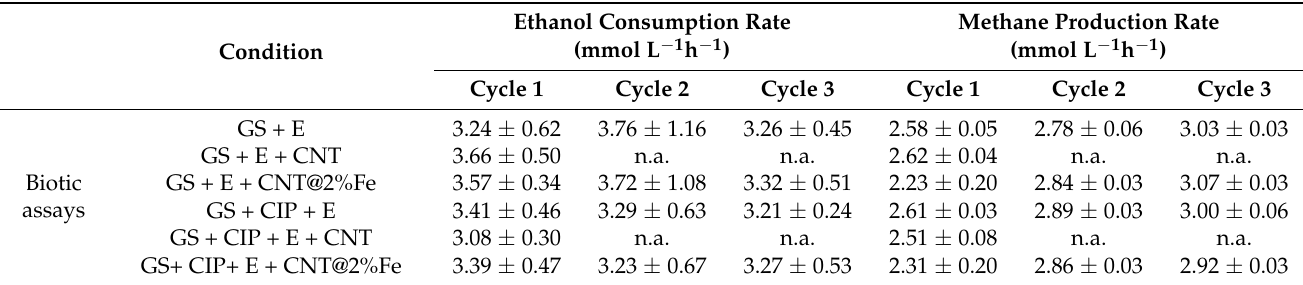
Table 4. Rates of ethanol consumption and methane production, over 3 cycles of biological removal of CIP in the presence of